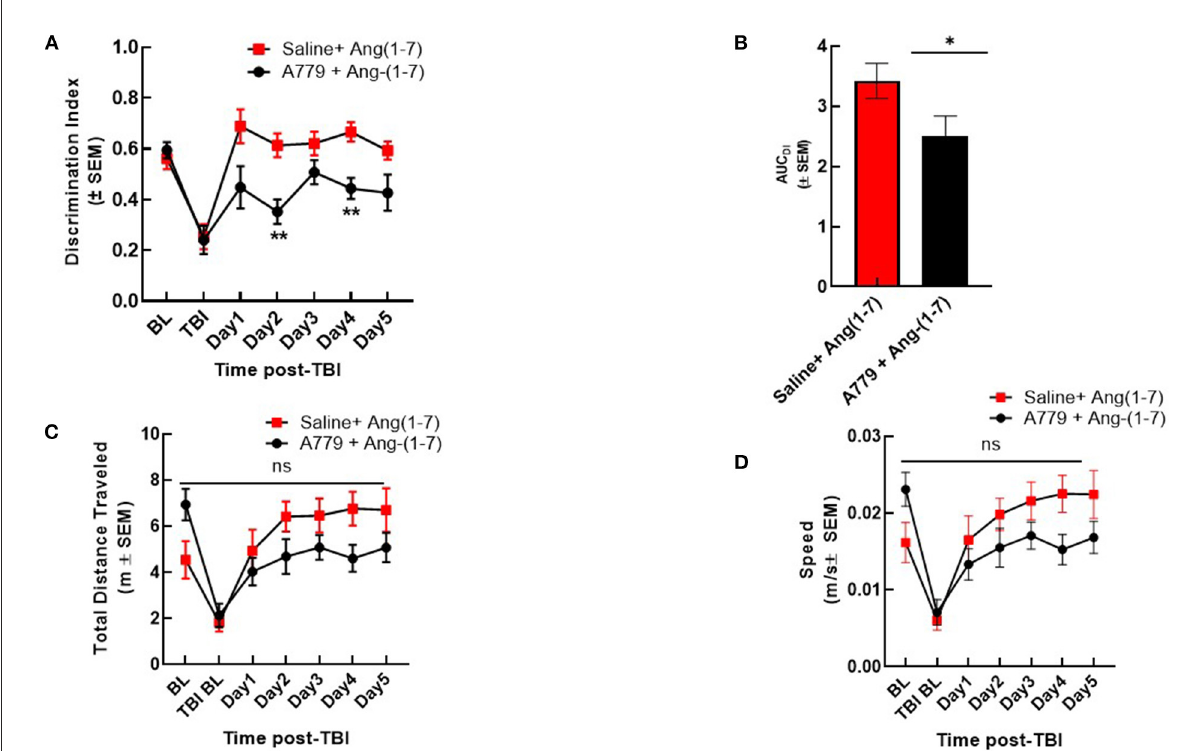
FIGURE3 A779 MASR antagonist pre-treatment attenuated Ang-(1-7)-mediated cognitive improvement. (A) The NOR discrimination index (DI) was statistically lower in A779 (1 mg/kg, i.p.)-pretreated animals vs. saline on days 2 and 4 of treatment post TBI ( * p < 0.05). (B) This was confirmed after calculation of the Area under the curve (AUC) to account for differences over time. (C,D) Showed no differences in total distance moved or speed were observed ( P > 0.05). Repeated measures ANOVA (with Tukey correction) was employed. N = 12 mice in each group. ** P < 0.01, ns; no significant.